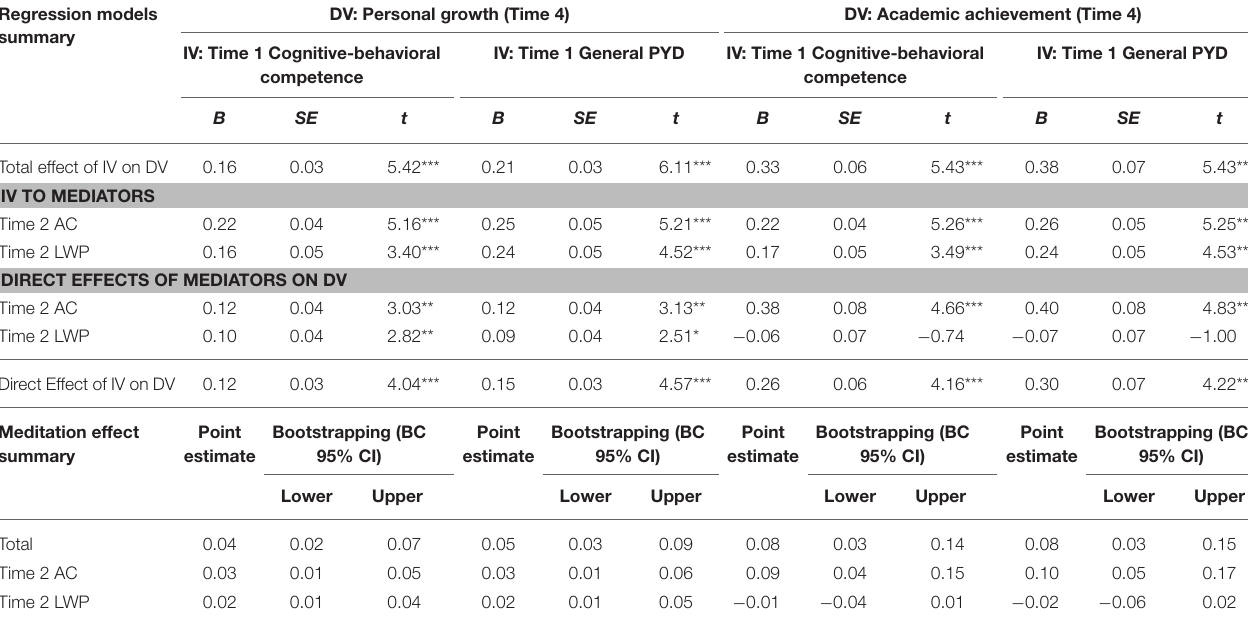
TABLE 2 | Mediation effect analyses with internal engagement at Time 2 as the mediator ( N = 425–427). Regression models summary